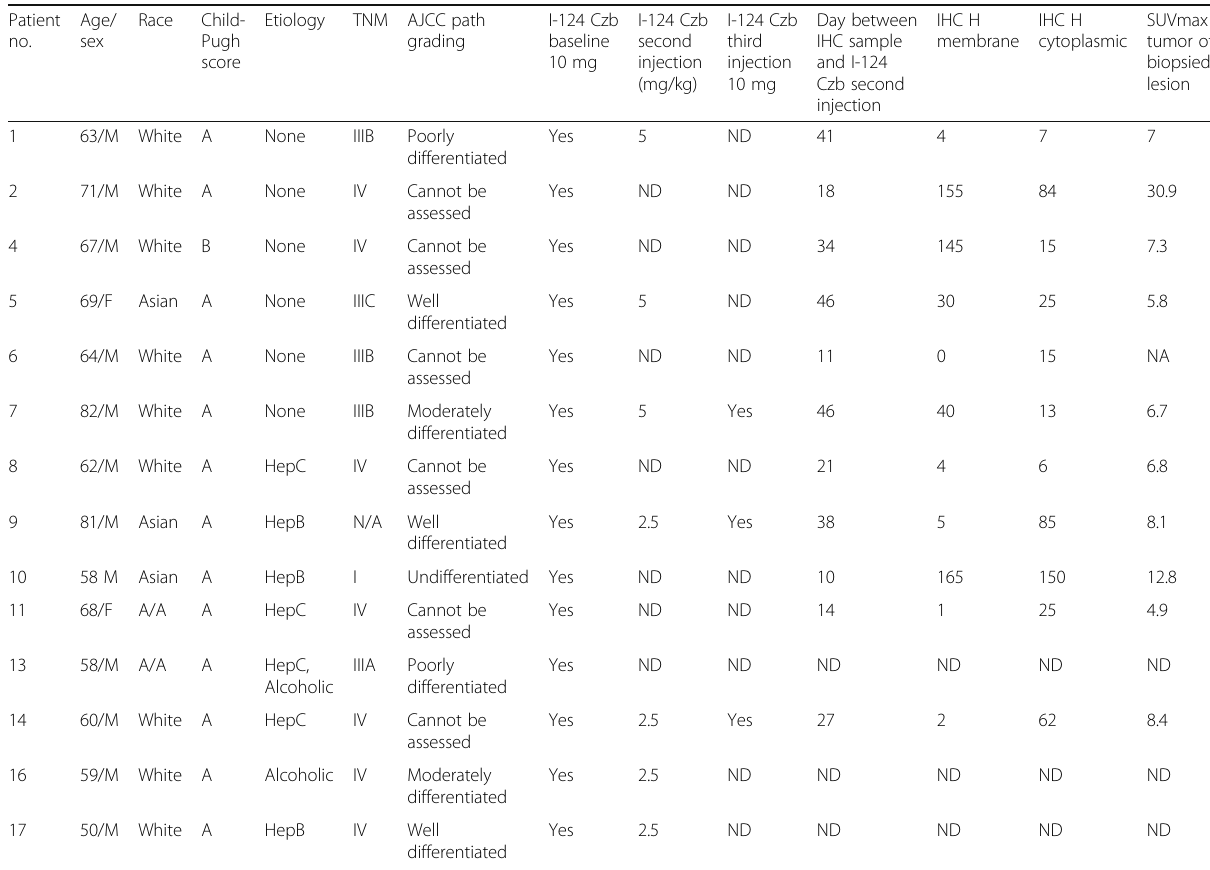
Table 1 Patient demographics, pathology, and imaging Patient